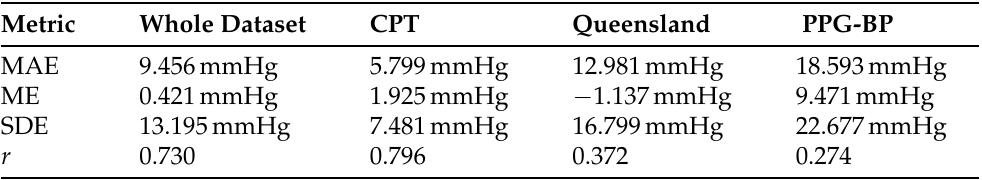
Table 3. Results of the prediction of our model for the all datasets combined and the single datasets separately.